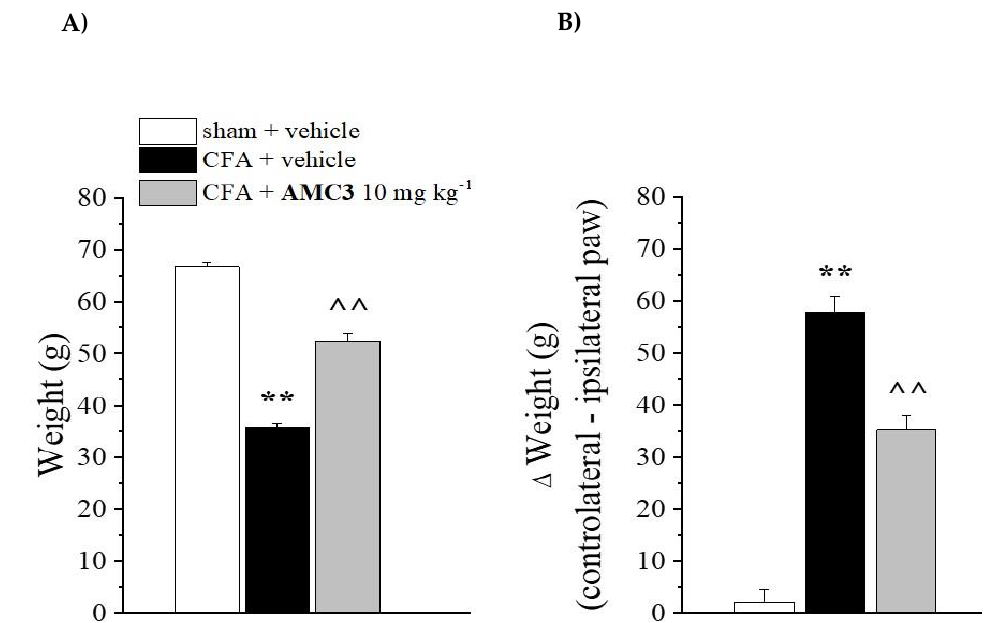
Figure 3. Pain relieving effect of AMC3 . CFA-treated rats received daily administration of